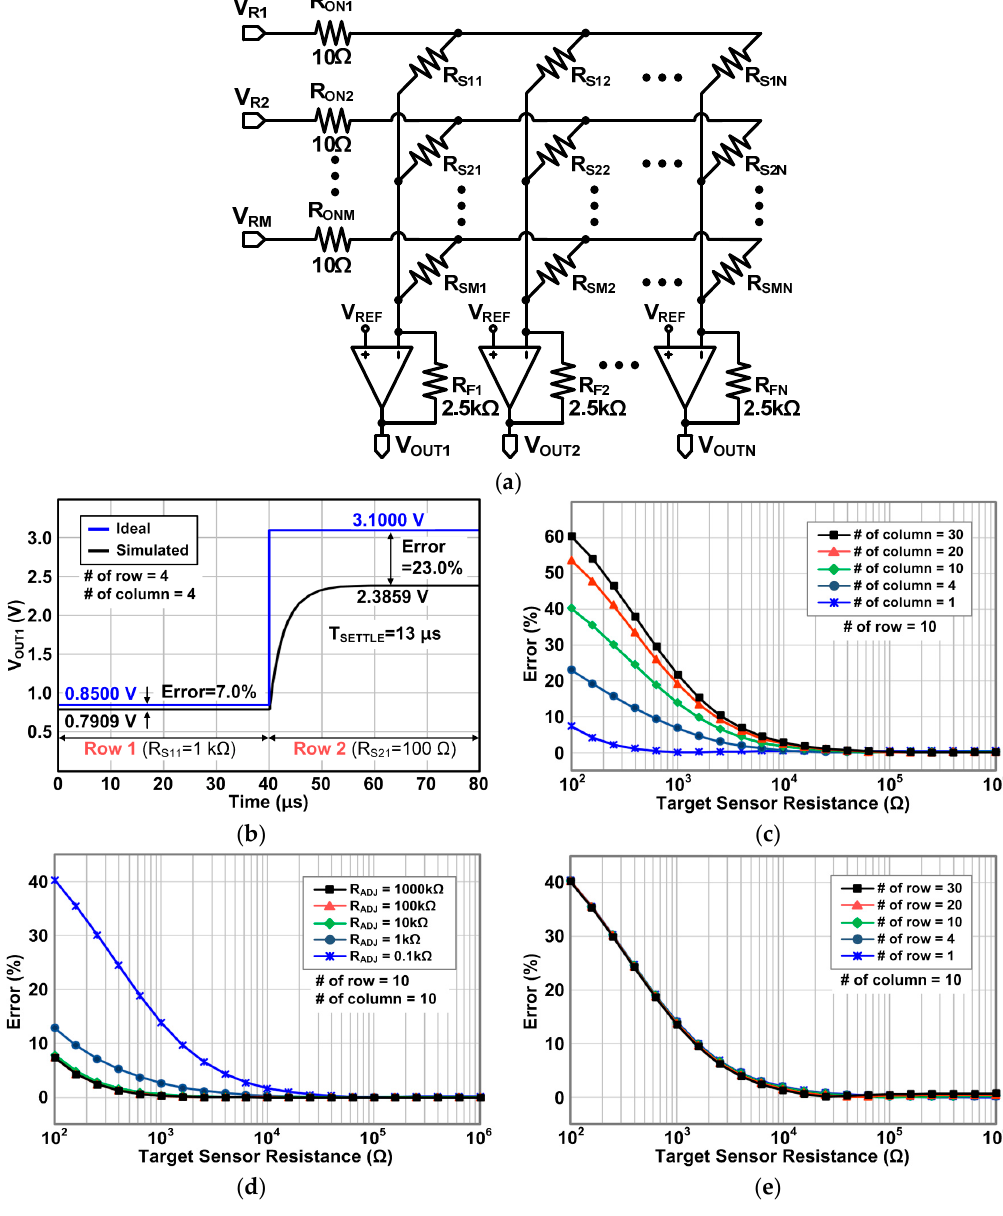
Figure 10. ( a ) Schematic for the simulations of the Type I row driver; ( b ) transient simulation results; ( c ) output errors as a function of the sensor resistance with different column numbers; ( d ) output errors as a function of the sensor resistance with different adjacent sensor resistance (R ADJ ), and ( e ) output errors as a function of the sensor resistance with different row numbers.